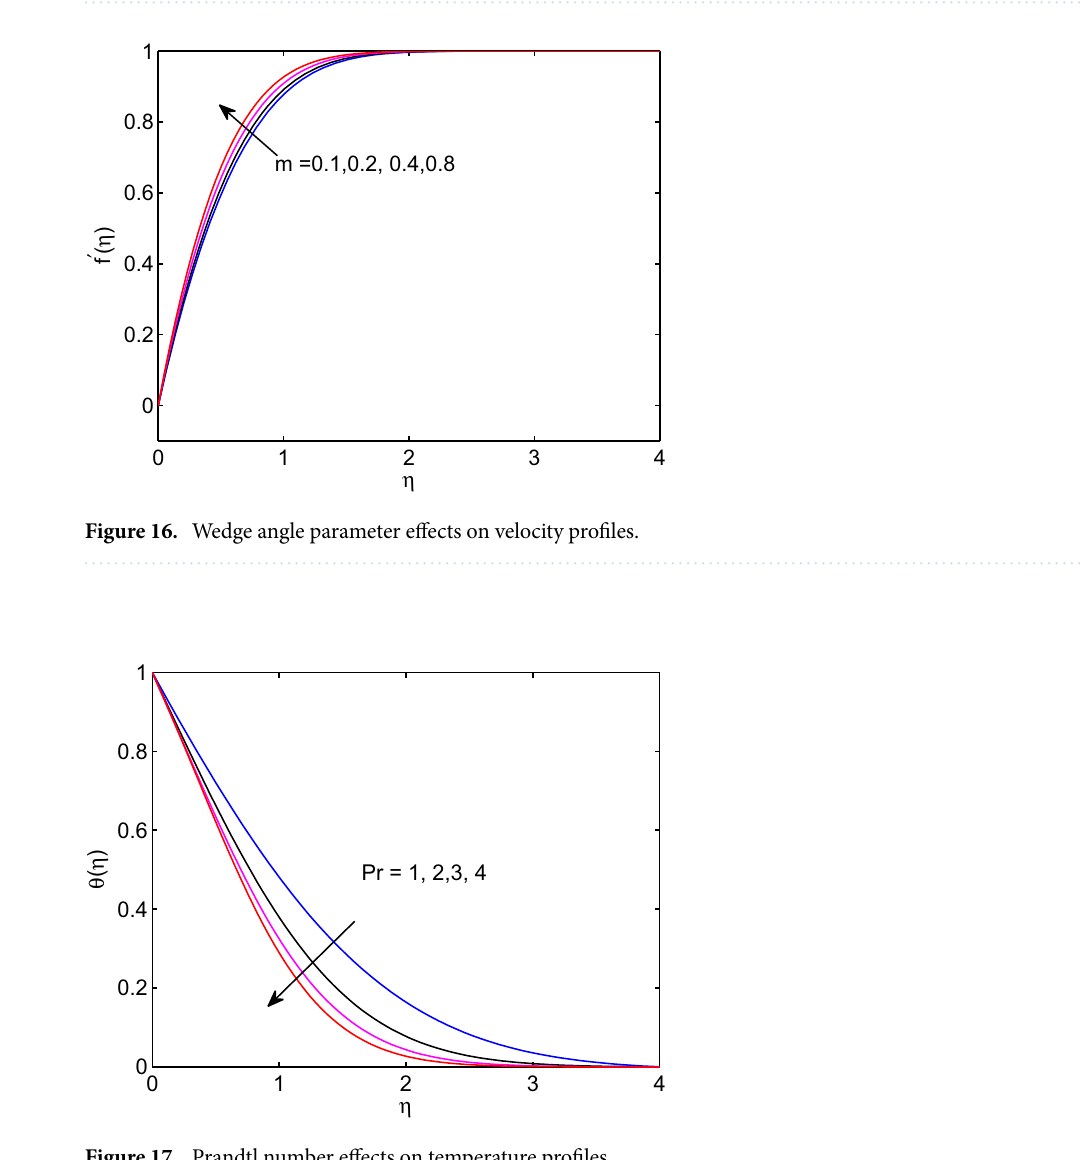
Figure 17. Prandtl number effects on temperature